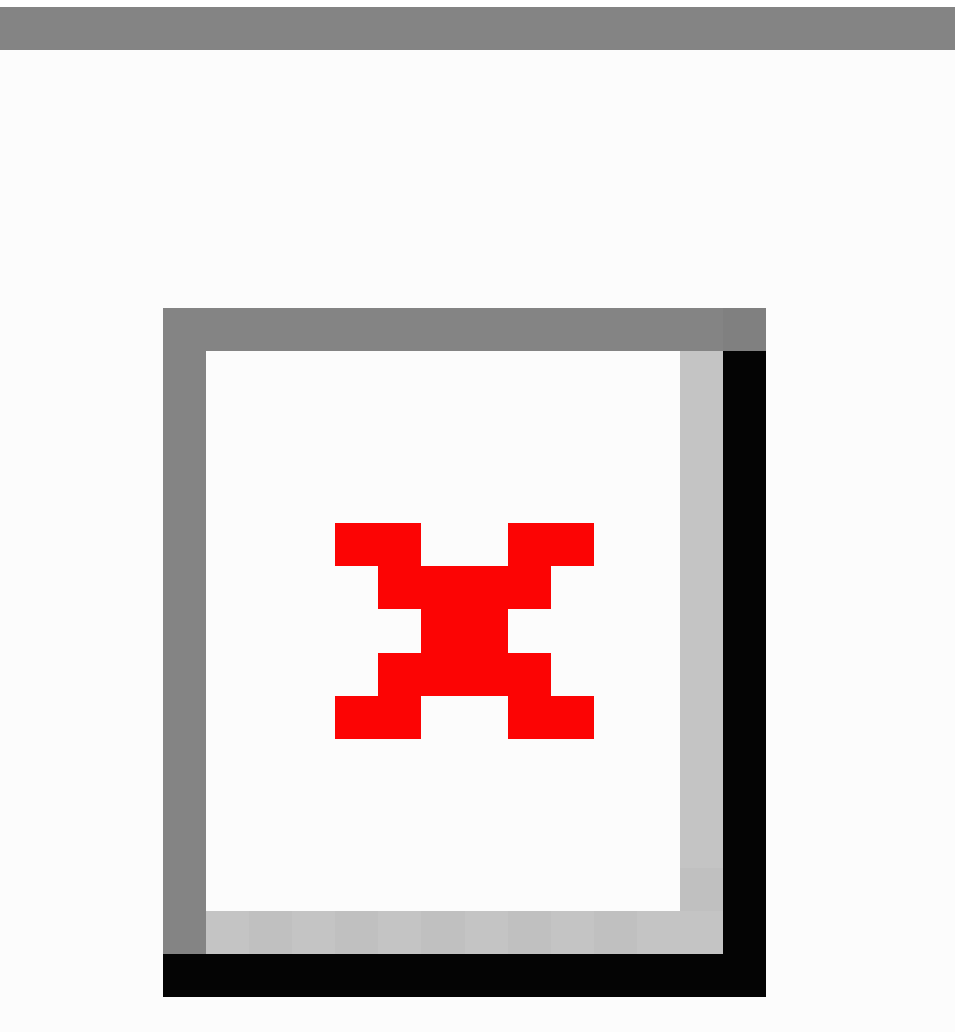
Figure 1. Weight misclassification compared to the time delay between online entry and validation visit (blue data points refer to dogs under 1 year of age and the red to those over 1 year of age, both with linear regression